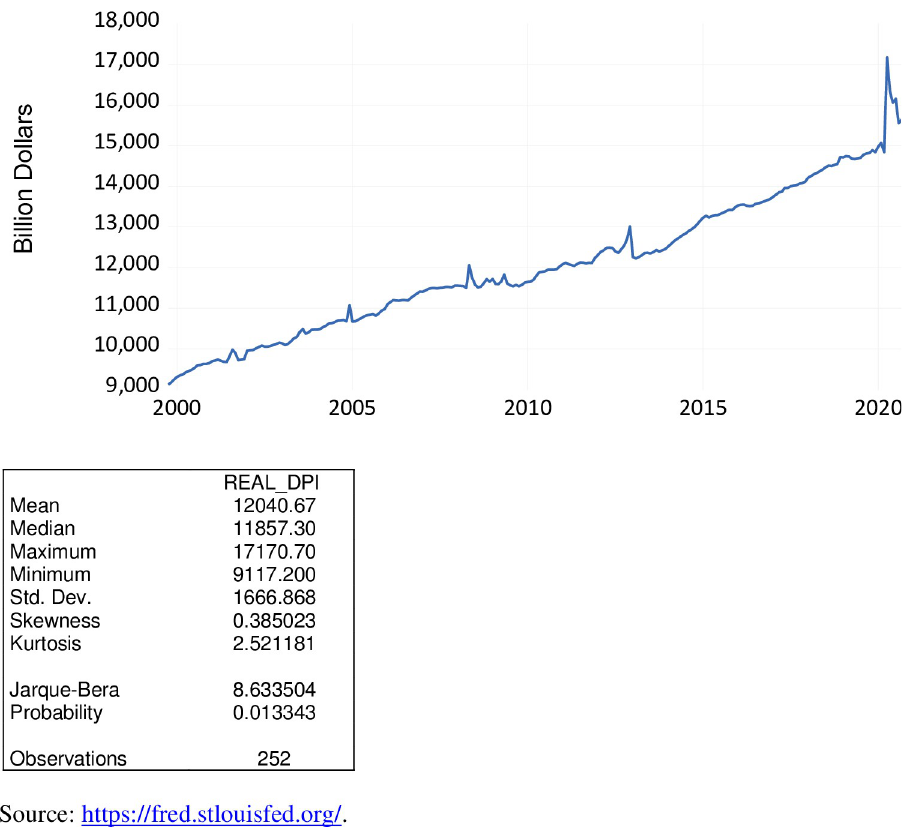
Fig 12. Real disposable personal income, billion $, October 1999 to September